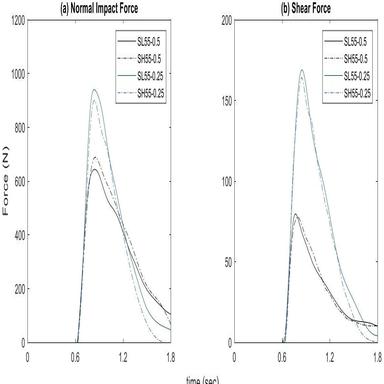
(a), (b) Impact forces on obstacles inducing partial obstruction to the flow, for 55◦ flume angle.